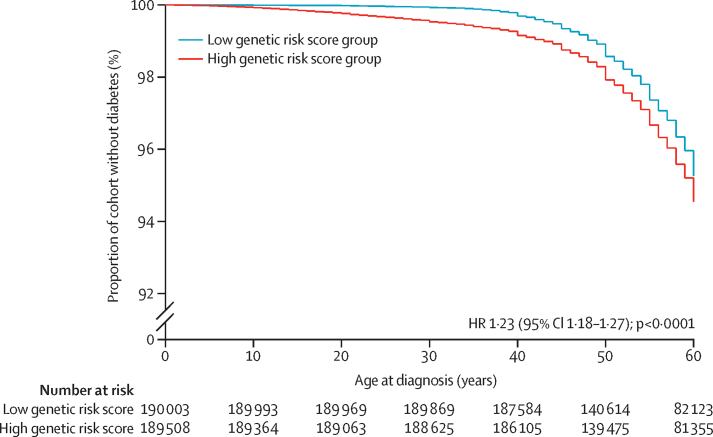
Kaplan-Meier curve of diabetes-free survival in the high and low genetic susceptibility groupsGraph shows that diabetes was more likely in the high genetic susceptibility group. HR=hazard ratio.